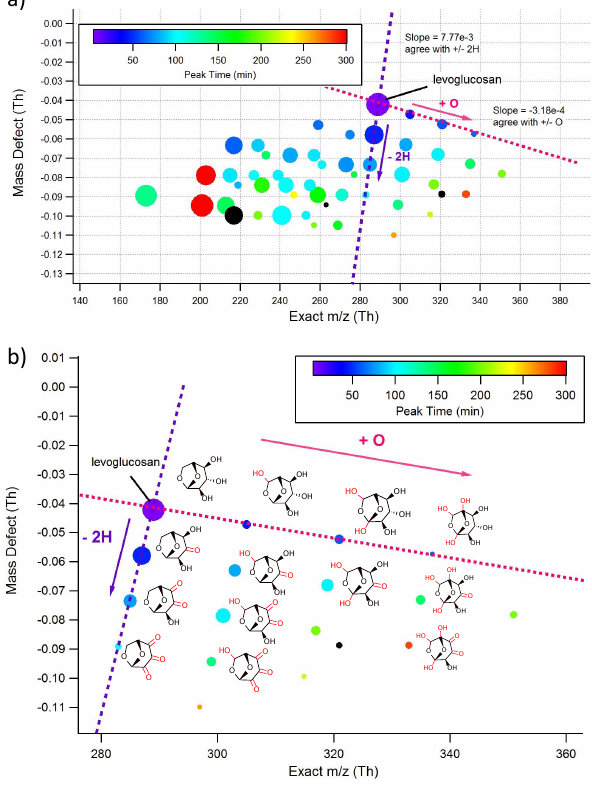
Figure 3. The mass defect diagram of the major products detected using the iodide water cluster (I ( H 2 O ) − n ) reagent ion (a) . The color code indicates the time at which each compound reached its maxi- mum signal intensity and the area of the circles represents the max- imum signal intensity reached (in log scale). Compounds that did not reach their maxima during the first 300min of illumination are shown in black. The + O and the − 2H series fall on the slope in- dicated by the dotted lines. The region relevant to products arising from + O and − 2H trends is presented in (b) . The proposed struc- tures of each product are shown beside the data points.